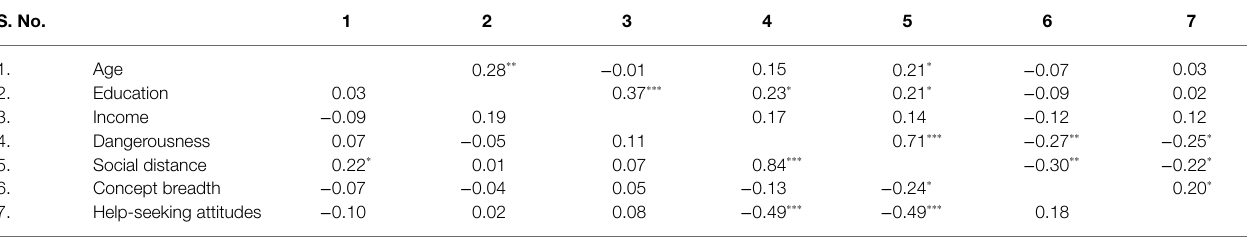
TABLE 2 | Correlations among variables by group. S. No.